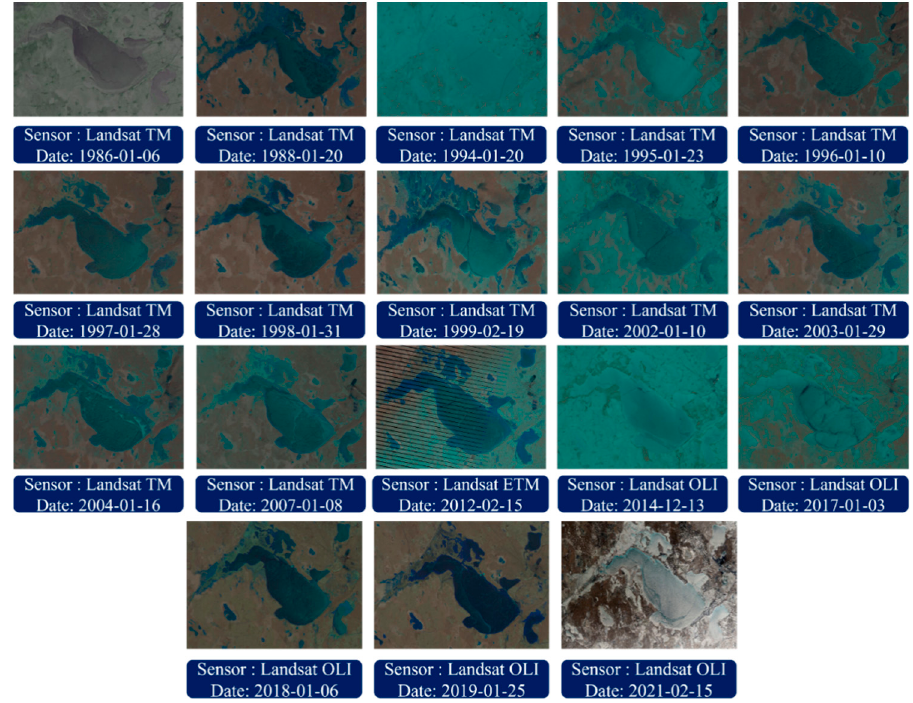
Figure 8 . The quick images of Landsat with similar cracks. We checked three sensors of Landsat for 35 cold seasons since 1986, including TM, ETM+, and OLI. 35 cold seasons since 1986, including TM, ETM+, and